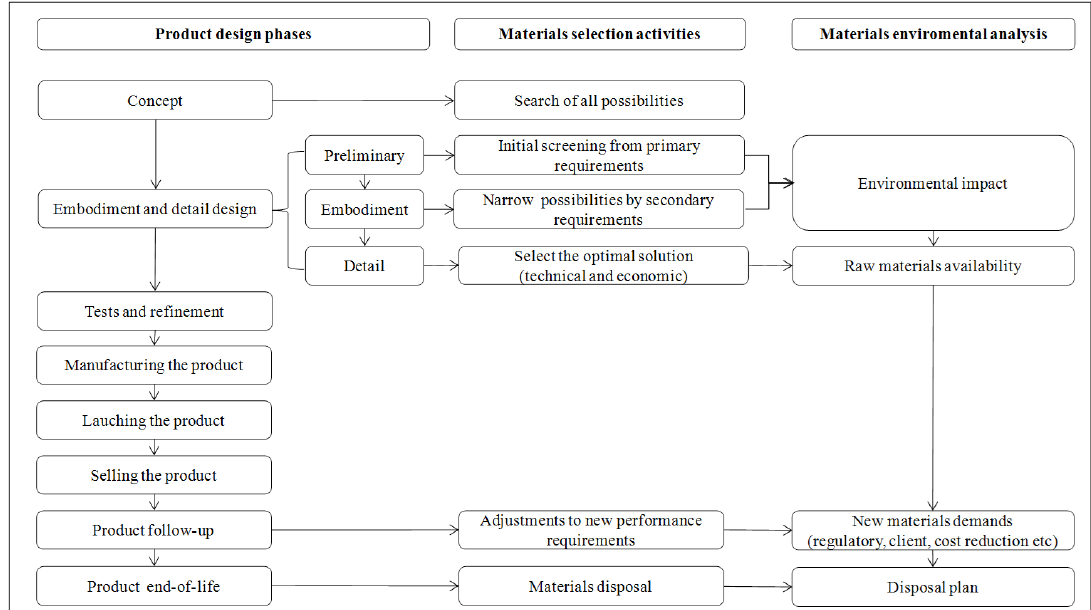
Figure 1: Selection activities and environmental analysis of materials in the product design 3,5,6-13